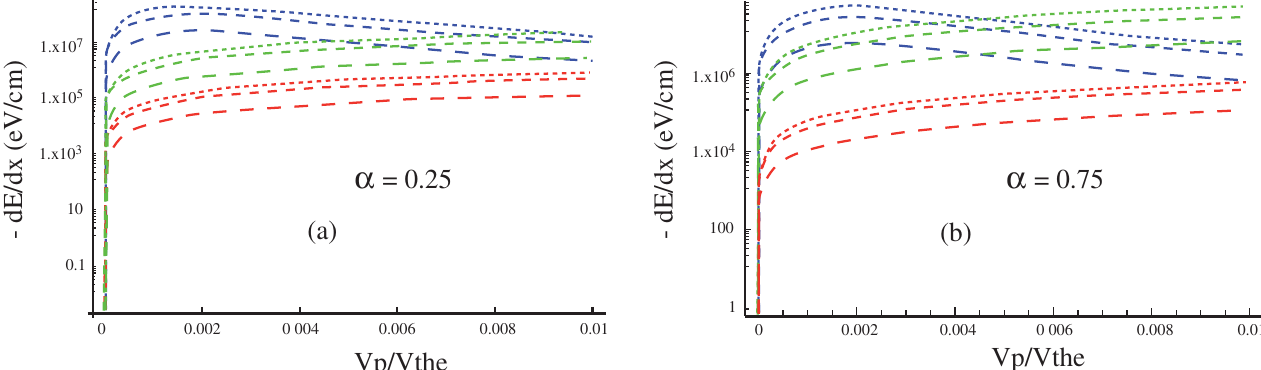
FIG. 4. (Color) Proton particle projectile in a proton- U þ 238 BIM with n e ¼ 10 26 e cm (cid:1) 3 and temperatures ¼ ( ) 1 keV, ( ) 5 keV, ( ) 10 keV, with H þ relative proportion: (a) (cid:1) ¼ 0 : 25 , (b) (cid:1) ¼ 0 : 75 . Dark gray (red) refers to electron stopping, light gray (green) to D þ stopping, and black (blue) denotes T þ stopping, (cid:1) dE=dx ( eV = cm ) in terms of V p =V the